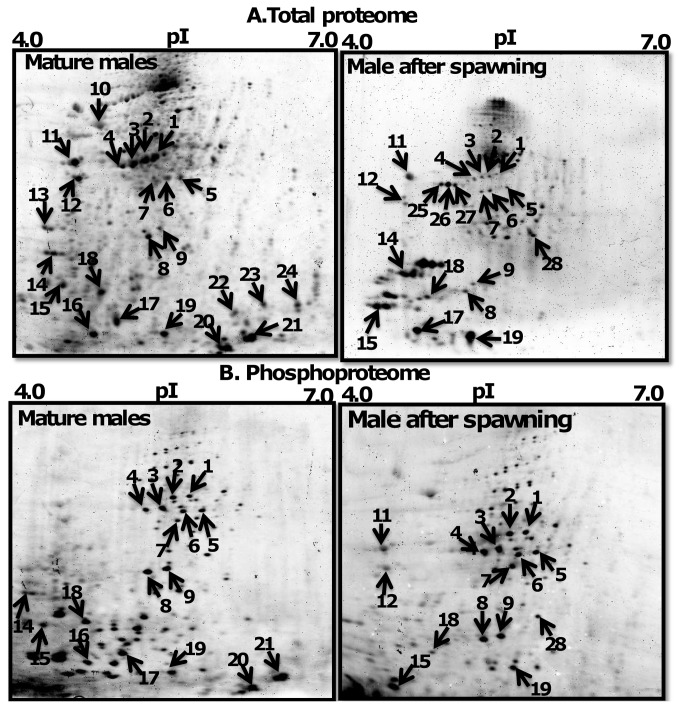
Proteome of mature males and males after spawning.2DE gels stained with Sypro Ruby dye to detect total protein (upper panel) and Pro-Q Diamond dye to detect phosphoproteins (lower panel). Protein spots marked with arrow were identified by mass spectrometry.